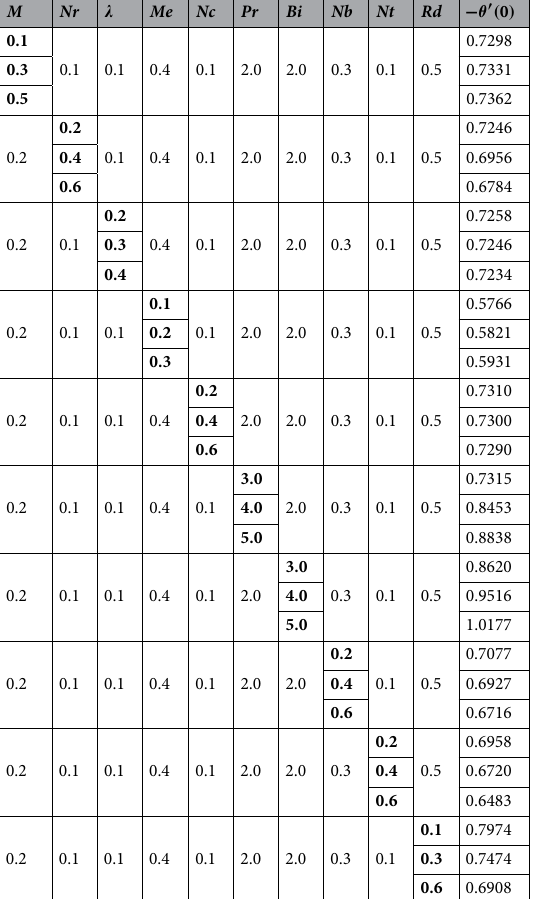
Table 3. Numerical computations of local Nusselt number Pr , Bi , Nb , Nt and Rd